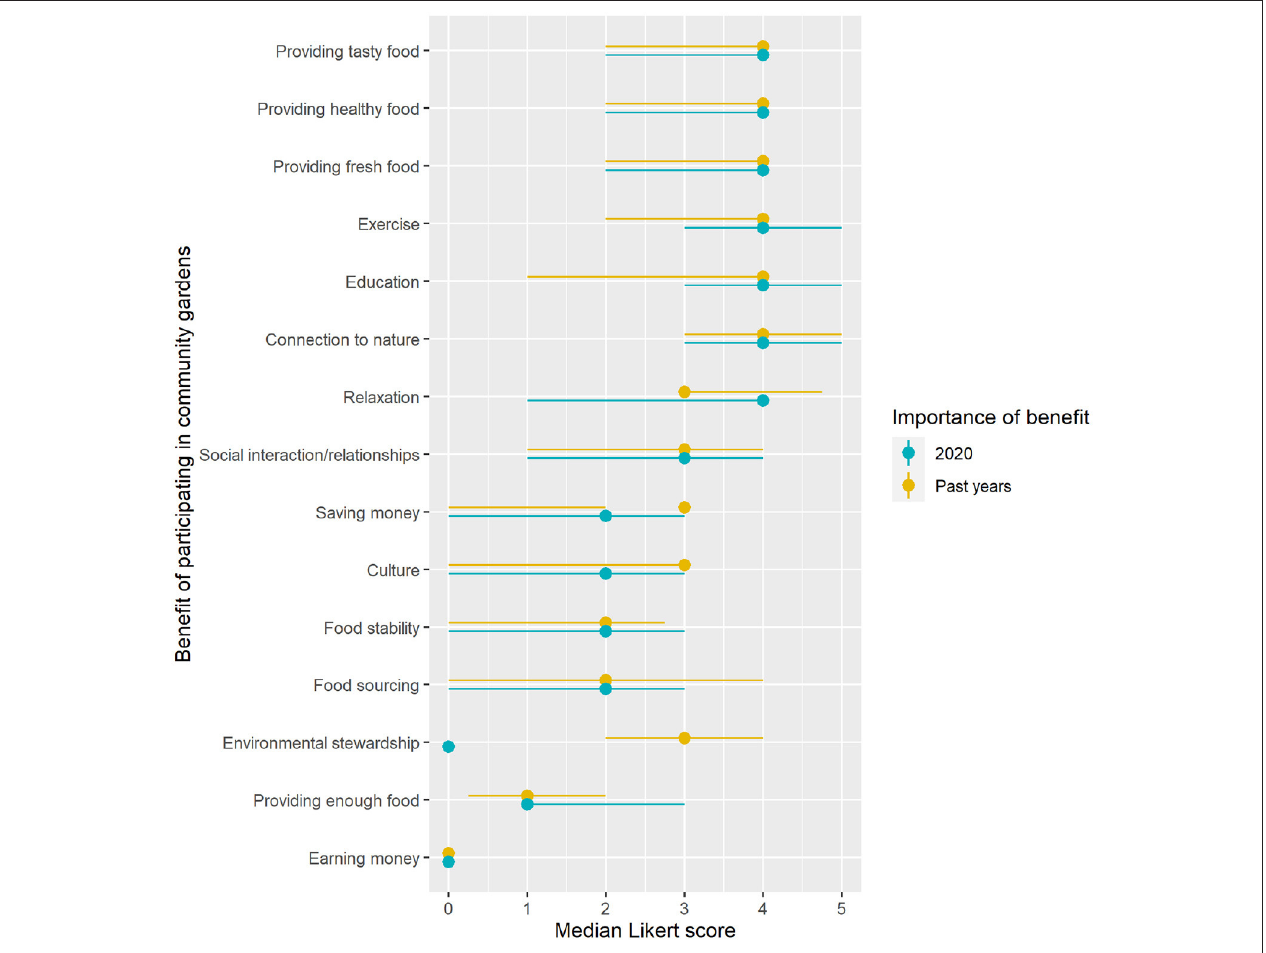
FIGURE 3 | Medians (points) and interquartile ranges (lines) for Likert scores describing the importance of various benefits of participating in community gardens (5 = essential, 4 = very important, 3 = important, 2 = somewhat important, 1 = appreciate but not important, 0 = not applicable/irrelevant).